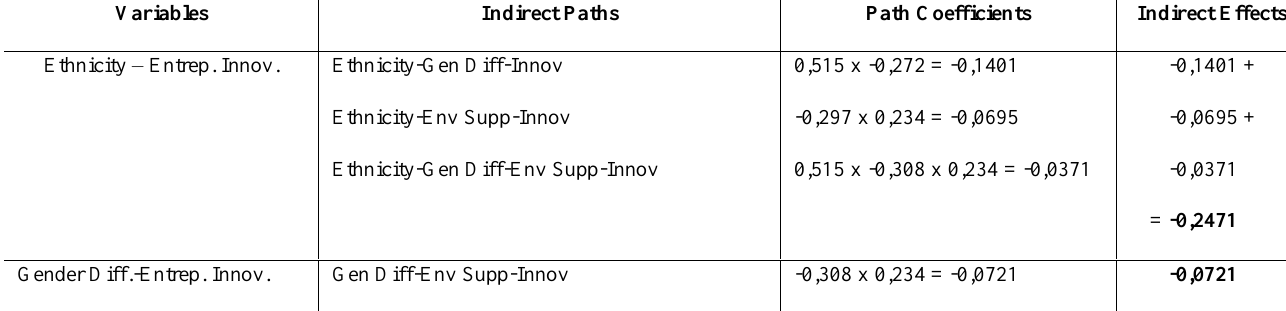
Gender Diff.-Entrep.